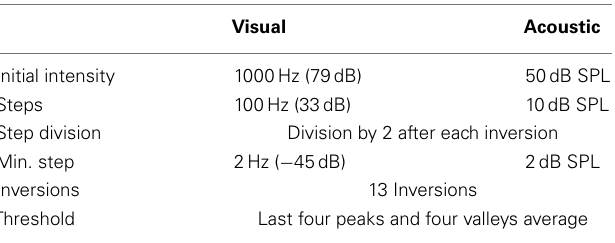
Table 1 | Parameters used according to the type of threshold search